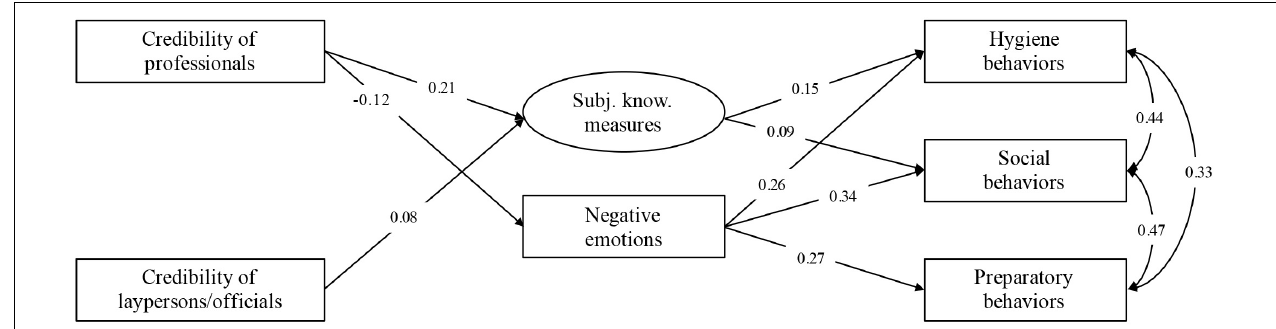
FIGURE 1 | Model for predicting the adherence to self-protective behaviors from perceived credibility of informational sources via subjective knowledge of proposed measures and negative emotions [ χ 2 (9) = 49.94, p < 0.001, CFI = 0.97, TLI = 0.93, RMSEA = 0.06 (95% CI = 0.04–0.07), SRMR = 0.03, BIC = 17080.69; MLR estimator]; all paths significant at p <